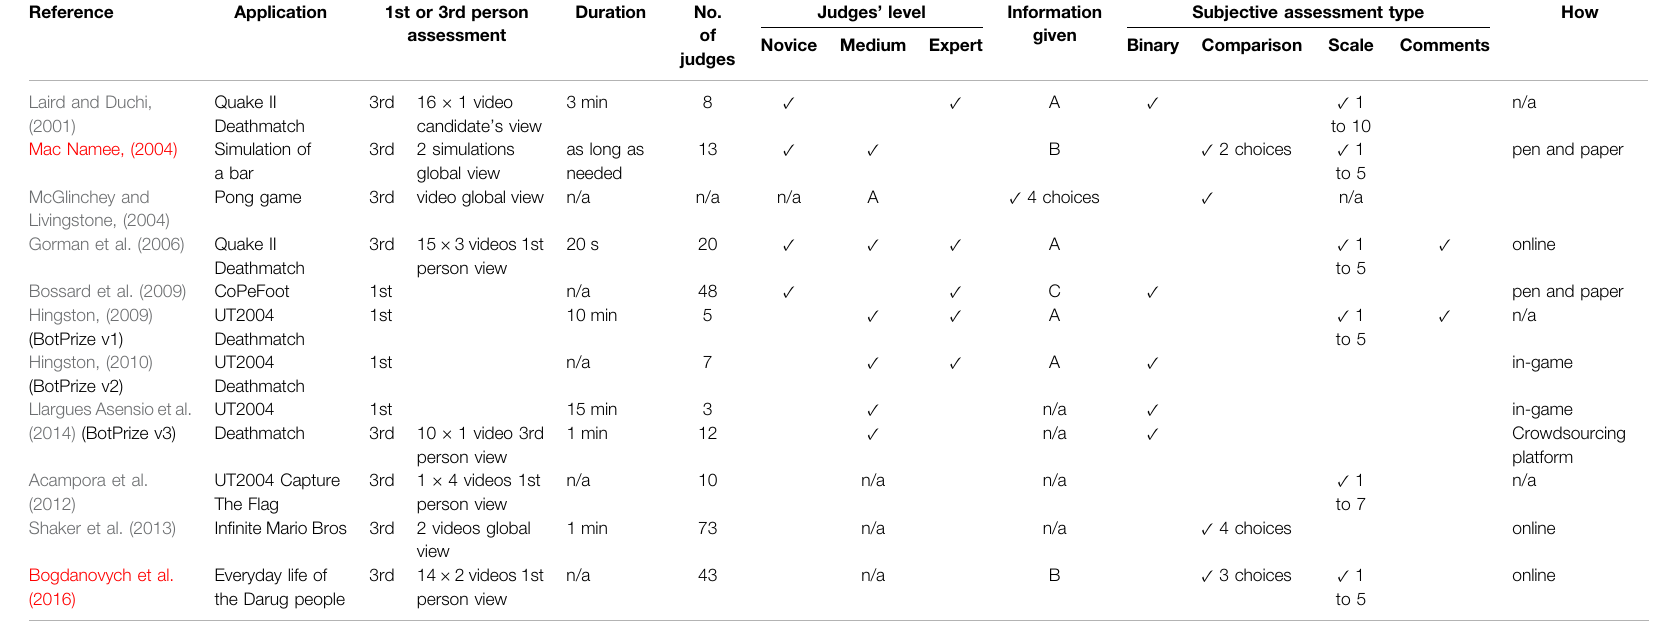
TABLE 1 | Comparison of the existing experiments from (Even et al.,